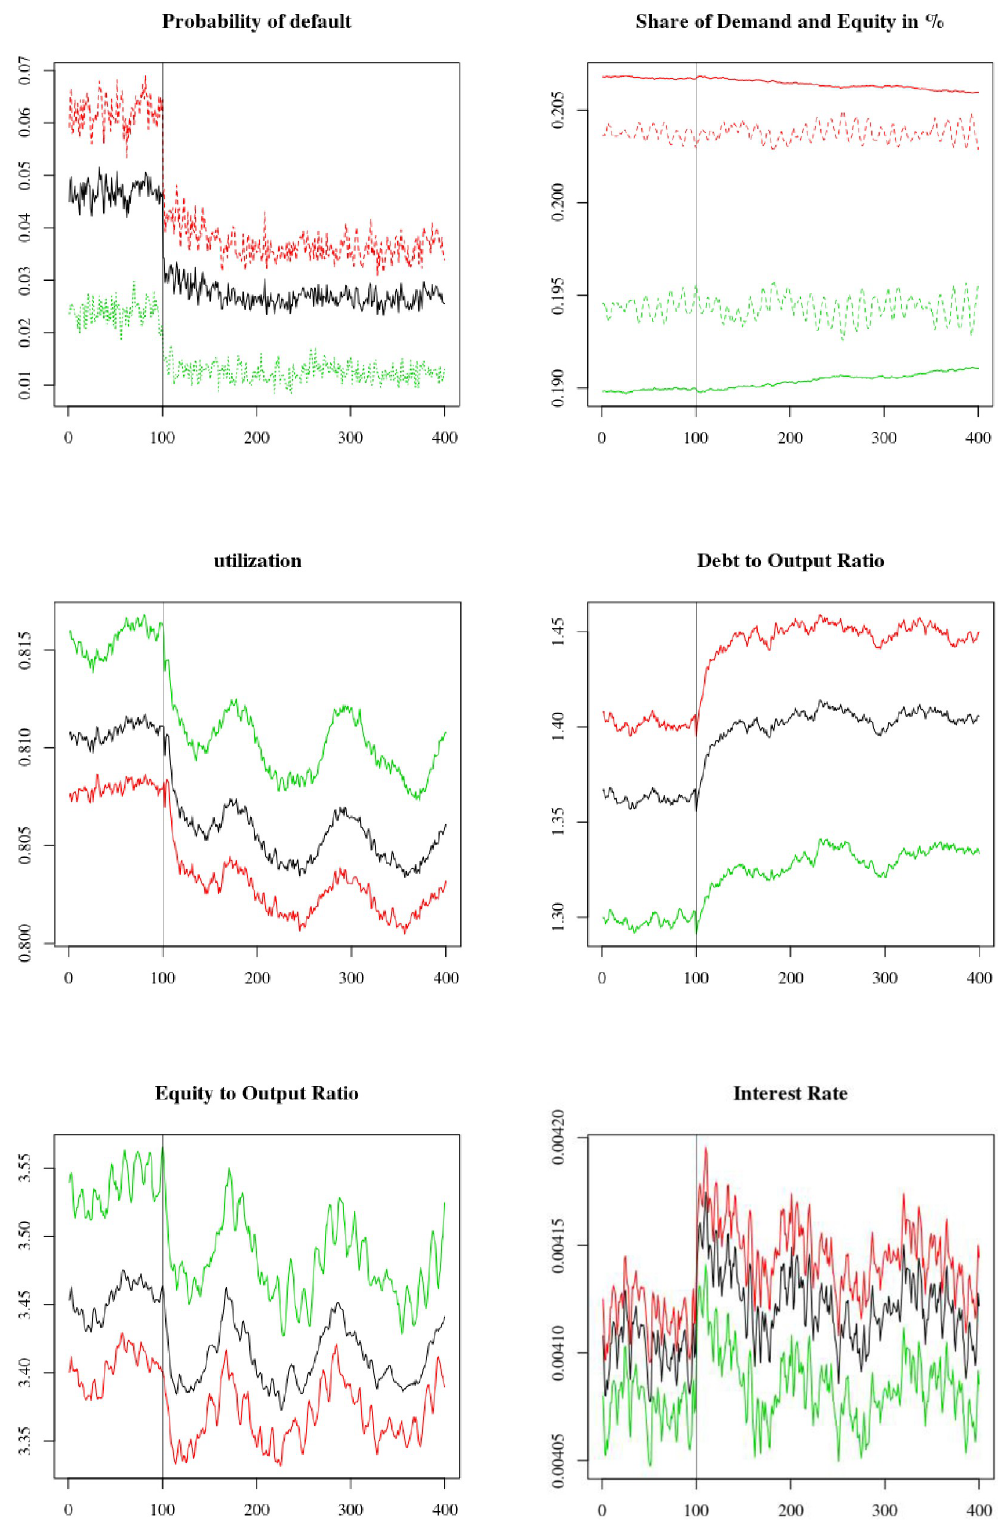
Fig 9. Firms’ liquidity ratio: Increase in the parameters λ firms (red) and neutral firms (green).